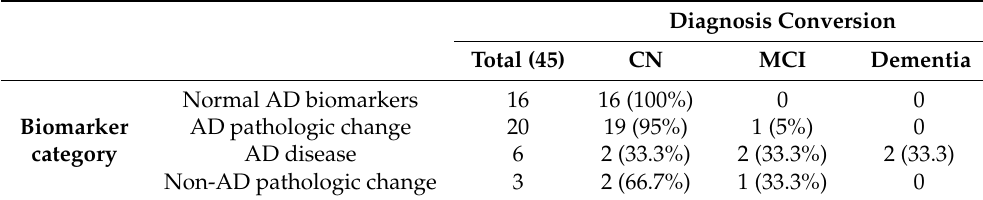
Table 4. Cognitively normal (CN) prospective clinical status based on biomarker category